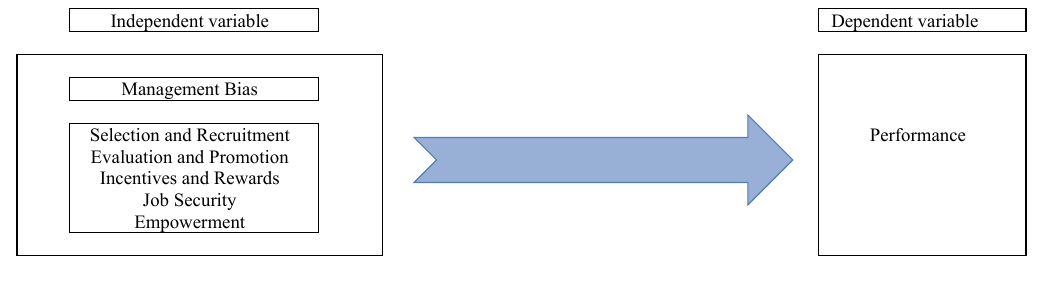
Fig. 1. Model of the